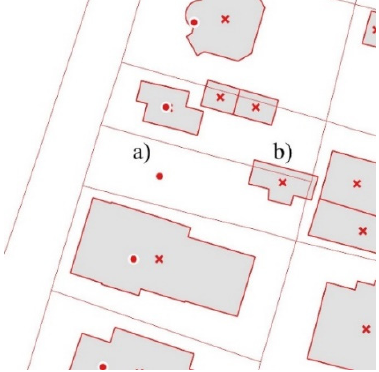
Figure 3. ( a ) Address and ( b ) building centroid within a single parcel.